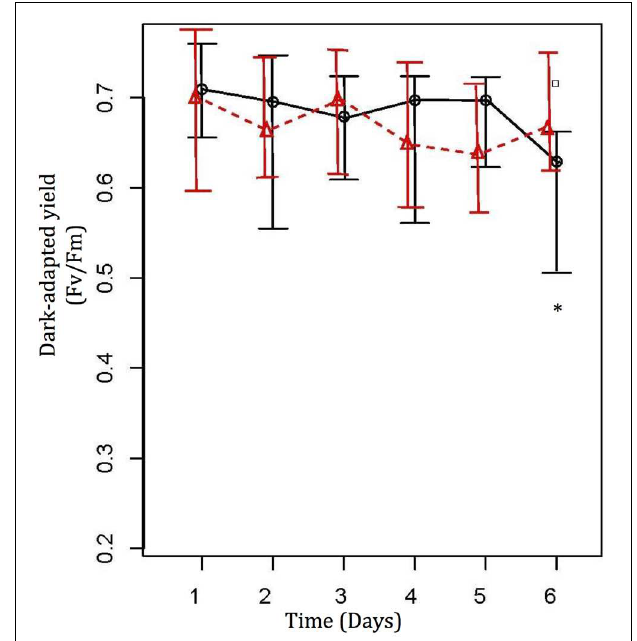
FIGURE 1 | Photochemical efficiency values (Mean ± SE) from Diving PAM for treatment (O) and control ( (cid:49) ) coral nubbins. Control coral nubbins were kept at a constant 26 ◦ C water temperature, whereas temperature in treatment tanks were increased 1 ◦ C per day from 26 to 31 ◦ C. ∗ Represents significant difference at 0.05. Symbol (cid:3) represents outliers (Lee et al.,